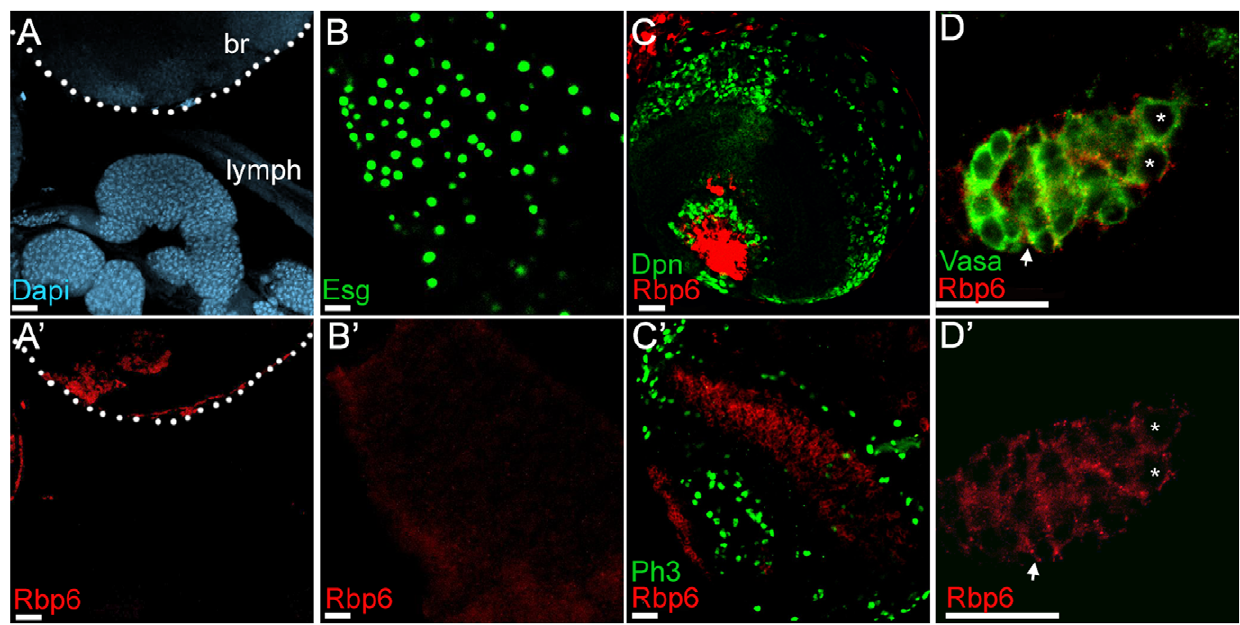
Figure 5. Rbp6 is not widely expressed in stem cell populations at different developmental stages. Rbp6 antibody staining (red in all panels) was not detected in the lymph gland (A–A’), the source of hematopoietic stem cells, in intestinal stem cells (which are identified by the expression of Escargot (green, B–B’), or in proliferating neuroblasts of the third instar larval brain, which are marked by either Deadpan expression (green, C) or phospho-histone H3 expression (green, C’). Rbp6 expression was detected at low levels in the germline stem cells (asterix) and possibly the somatic stem cells (arrow) of the adult ovary (D–D’). Scale bars: 20 m m. br represents the brain lobe (A–A’).